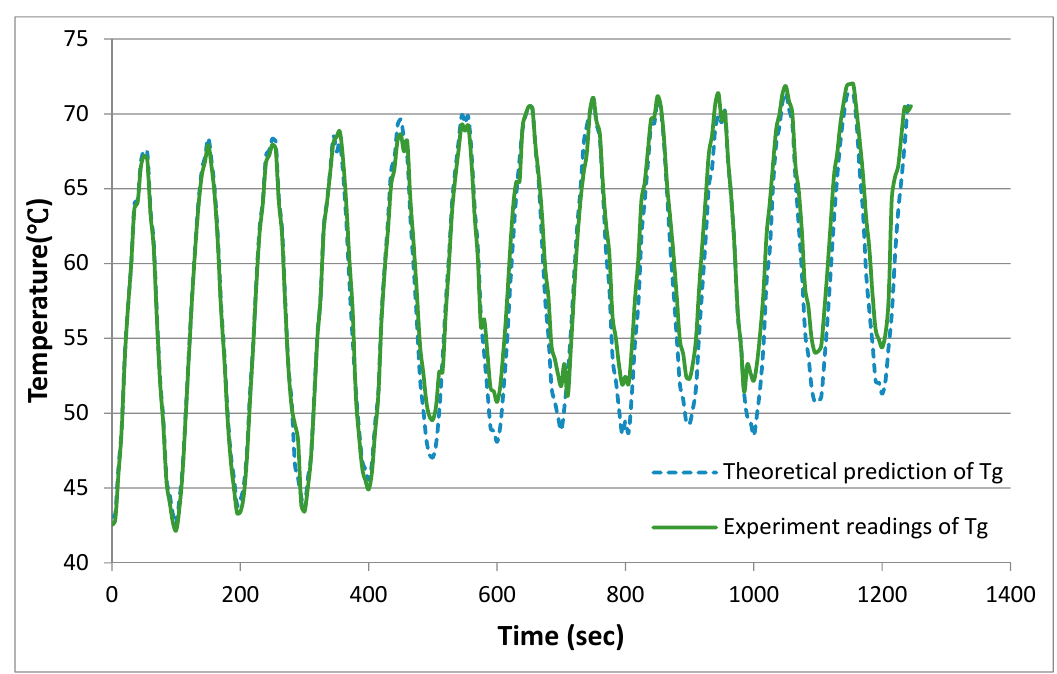
T of 0.01 Hz operation. Figure 9. Displacer chamber gas temperature T g of 0.01 Hz operation. Energies 2020 , 13 , x FOR PEER REVIEW